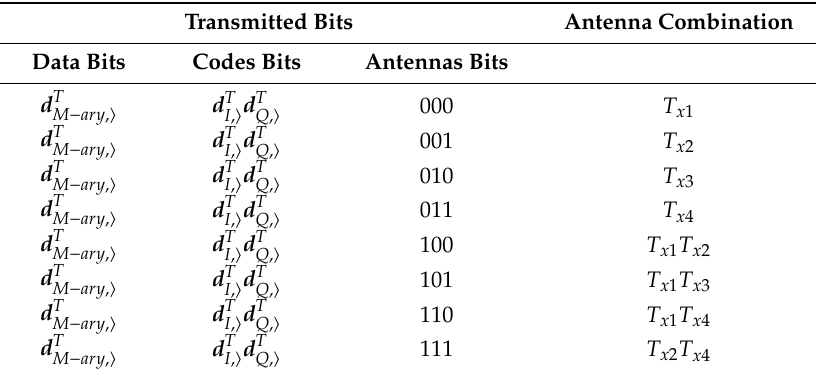
Table 2. Example of SS-FGSM